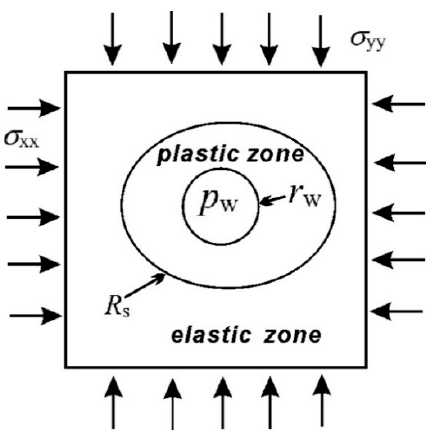
Figure 2. Stress zone variation around the borehole when high pressure fluids are injected. R s and r w are the radius of the plastic zone and borehole, respectively.